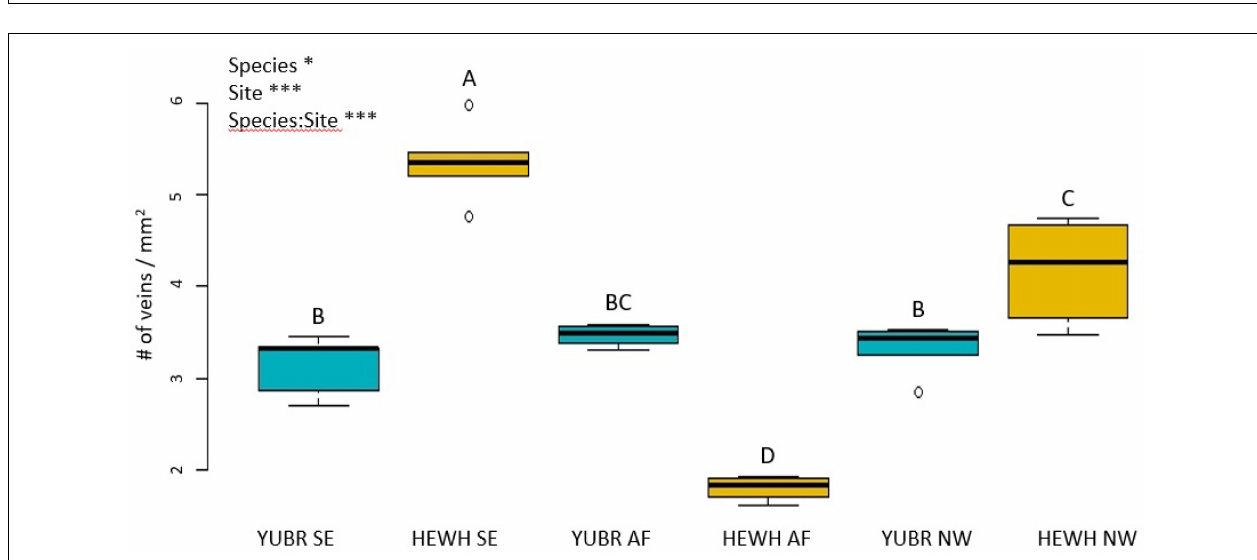
FIGURE 7 | Maximum leaf thickness varied significantly across sites and species. Different letters denote statistically significant differences ( p < 0.05) by single-factor ANOVA followed by a Tukey-Kramer post hoc test. YUBR = Y. brevifolia ; HEWH = H. whipplei ; SE, south-eastern slope; AF, alluvial fan; NW, north-western slope. n = 7–10 leaves per species per site. *** p < 0.001; ** p < 0.01.